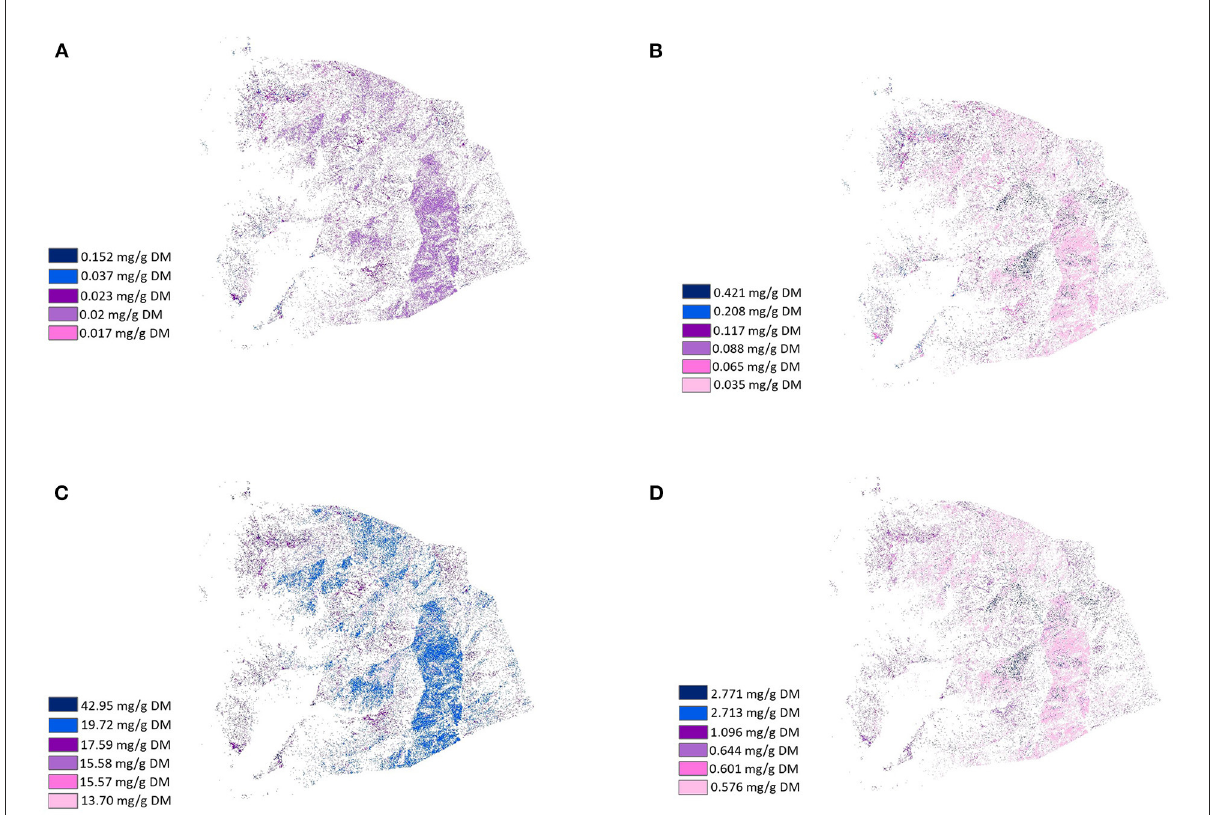
FIGURE5 Healthscape maps presenting the distribution and location of the variety of fatty acids chain according to their concentration in plants (mg/g DM) from LUMGS (Darkest color means the highest concentration). (A) Short chain, (B) Medium chain, (C) Long chain, and (D) Very long